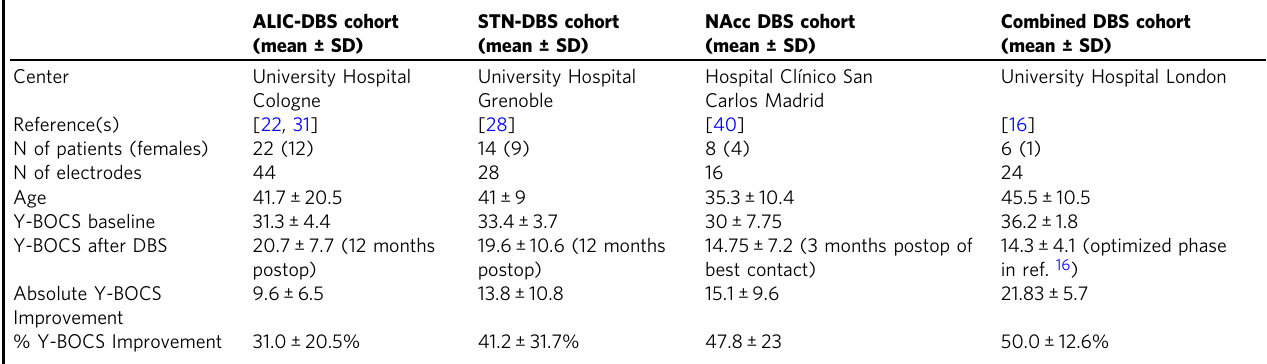
Table 1 Patient demographic details and clinical results of the two cohorts.